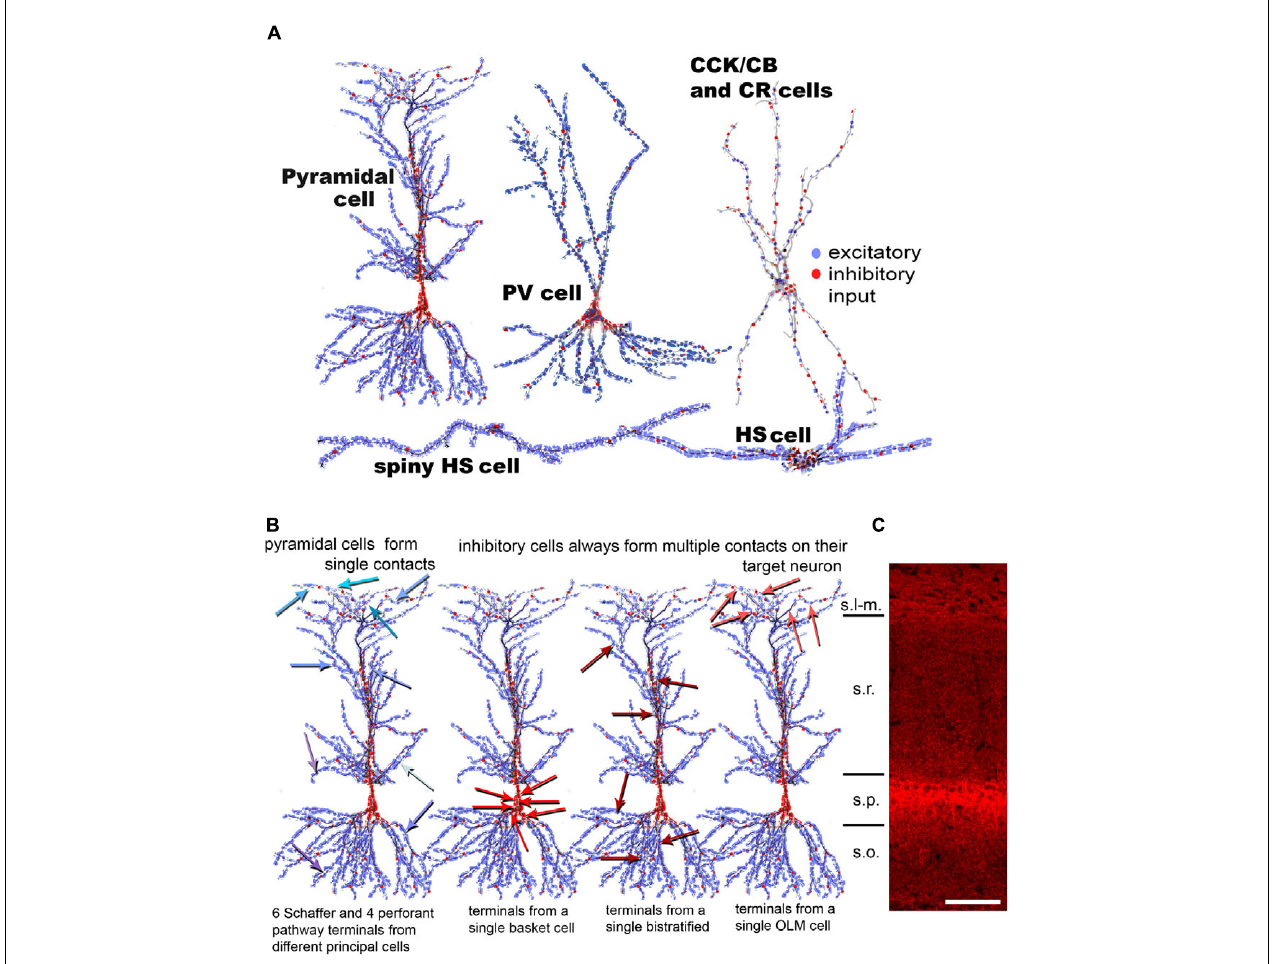
FIGURE 1 | Summary of observed synaptic distribution on different cell types of the hippocampal CA1 area. (A) The distribution of excitatory (blue) and inhibitory (red) terminals is shown schematically over different CA1 neurons. CCK, Calbindin D28k (CB) and CR cells have a similar input organization; therefore, they are represented by a single drawing. Hippocampo-septally projecting neurons (HS cells) receive the highest amount of excitation and the lowest amount of inhibition. (B) The distribution of input terminals from different types of presynaptic neurons onto a CA1 pyramidal cell (PC) is shown here. Excitatory input from CA3 PCs onto CA1 PCs in str. radiatum and oriens (Schaffer collaterals) and from the entorhinal cortex in str. lacunosum-molaculare are realized via single contacts. Single contacts from many different individual excitatory axons are indicated with arrows in different shades of blue on the left drawing. In contrast, all examined inhibitory neuron (IN) populations form multiple synapses (6–10) on their target PCs, by either clustering on the soma (second cell) or scatter individually over the dendritic domains (third and fourth cells). The data presented in the figure is a summary of results from our earlier anatomical results (Gulyás et al., 1999; Megías et al., 2001; Mátyás et al., 2004; Takács et al., 2008). (C) Fluorescent immunostaining against the vesicular GABA transporter (courtesy of Gábor Nyíri) reveals the distribution of GABAergic terminals in the CA1 area of the hippocampus. The panel shows that the density of inhibitory terminals is highest in and close to str. pyramidale (perisomatically) and in st. lacunosum-moleculare (the termination zone of the perforant path fibers). Scale 100 µ m. s.l-m.:stratum lacunosum-moleculare, s.r.: stratum radiatum, s.p.: stratum pyramidale, s.o.: stratum